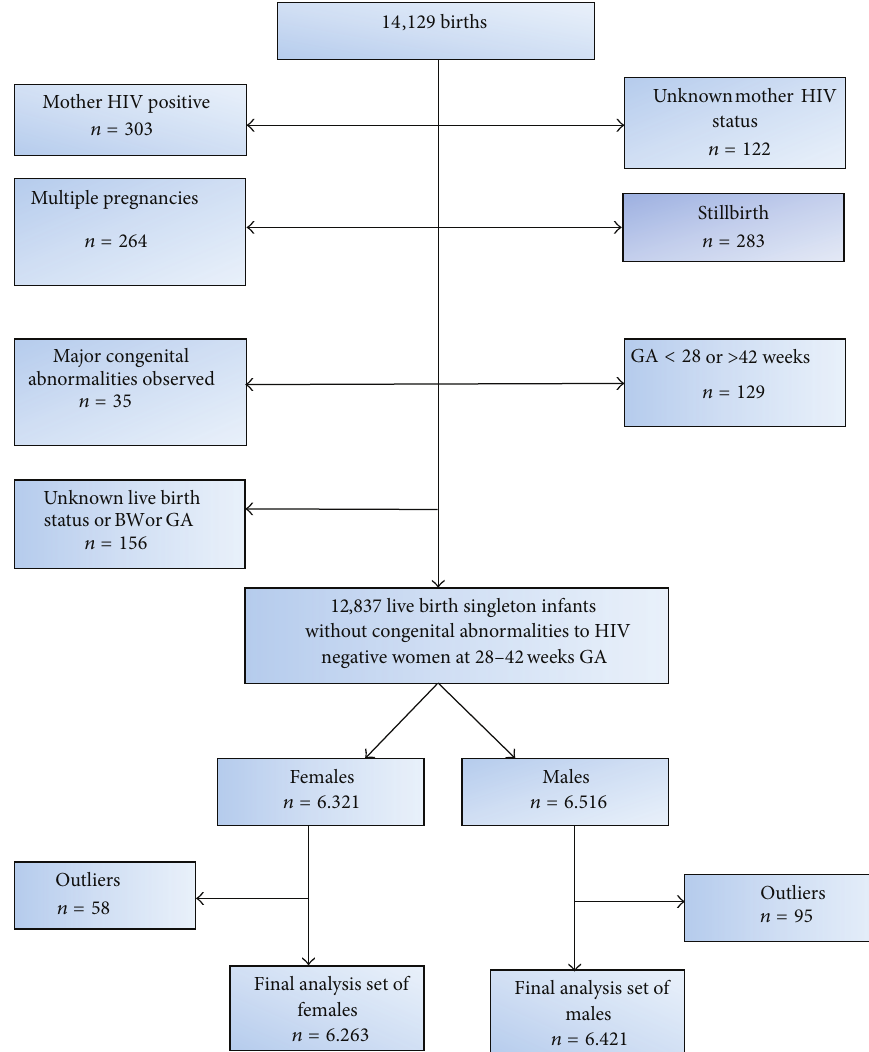
Figure 3: Selection of analysis dataset of births. GA: gestational age; BW: birth